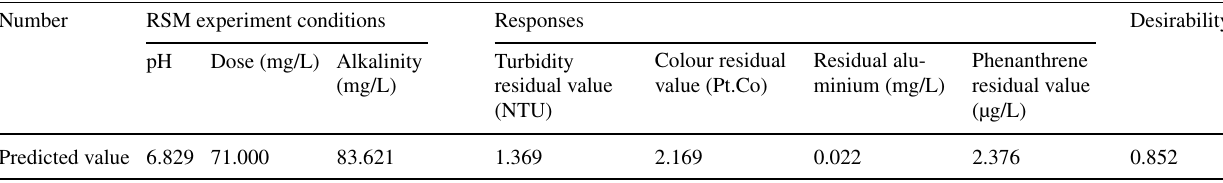
Table 8 RSM optimum conditions and response concentrations at desirability target